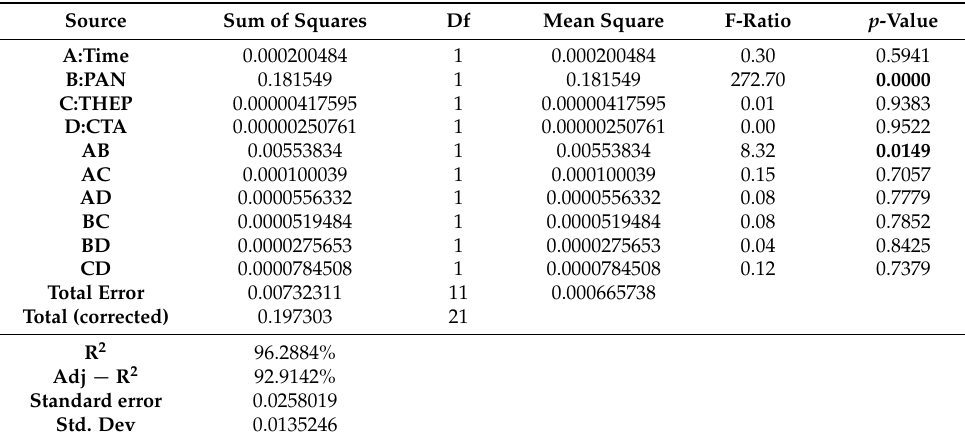
Table 5. Summary of the optimization results for the membranes prepared with PAN using M2 in the determination of Hg(II), Pb(II), and